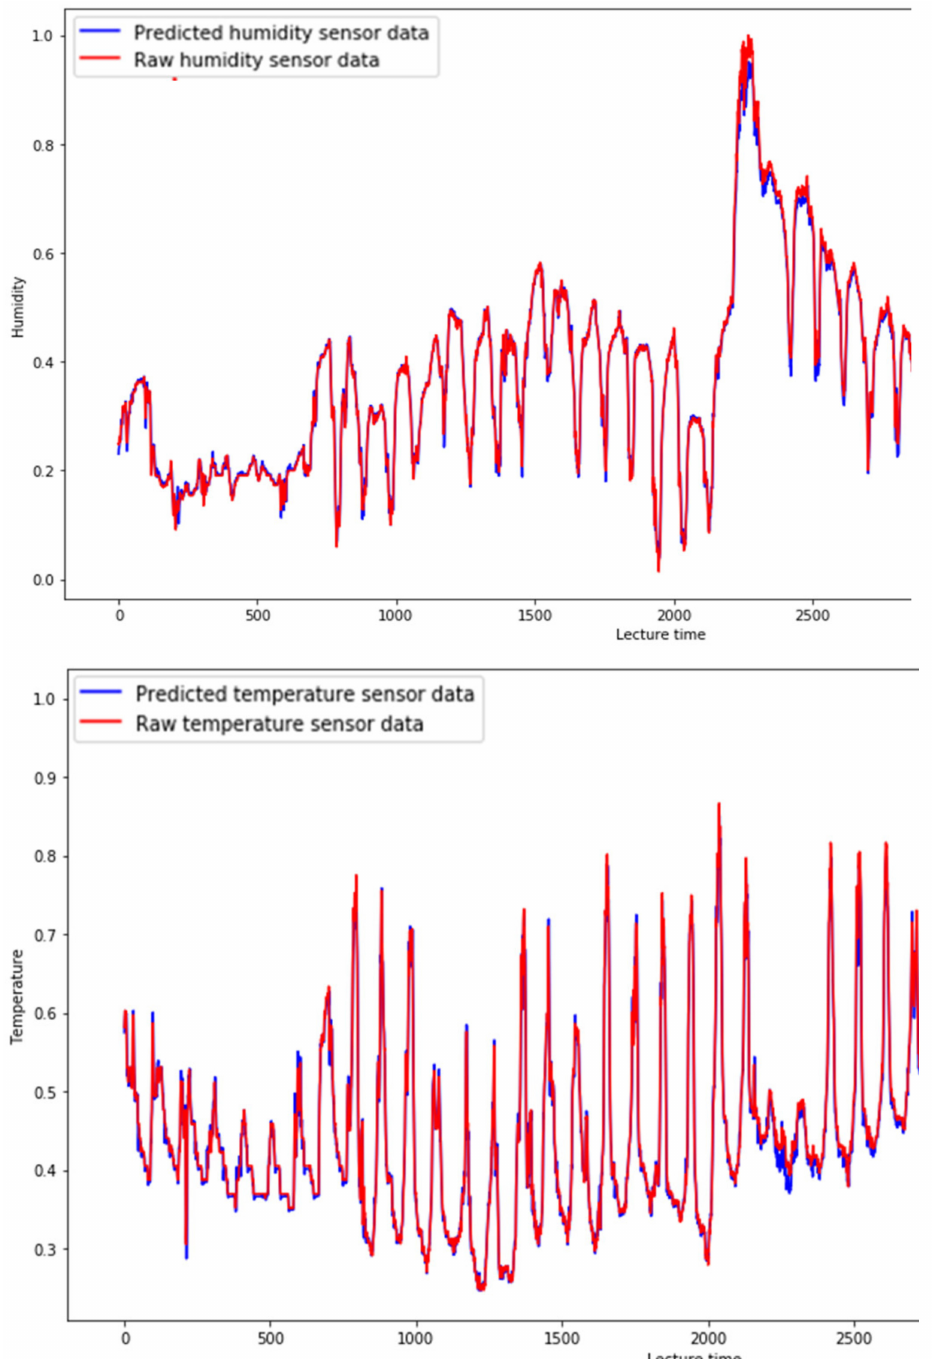
Figure 6. Predicted sensor output plot of humidity and temperature versus the lecture hour in the